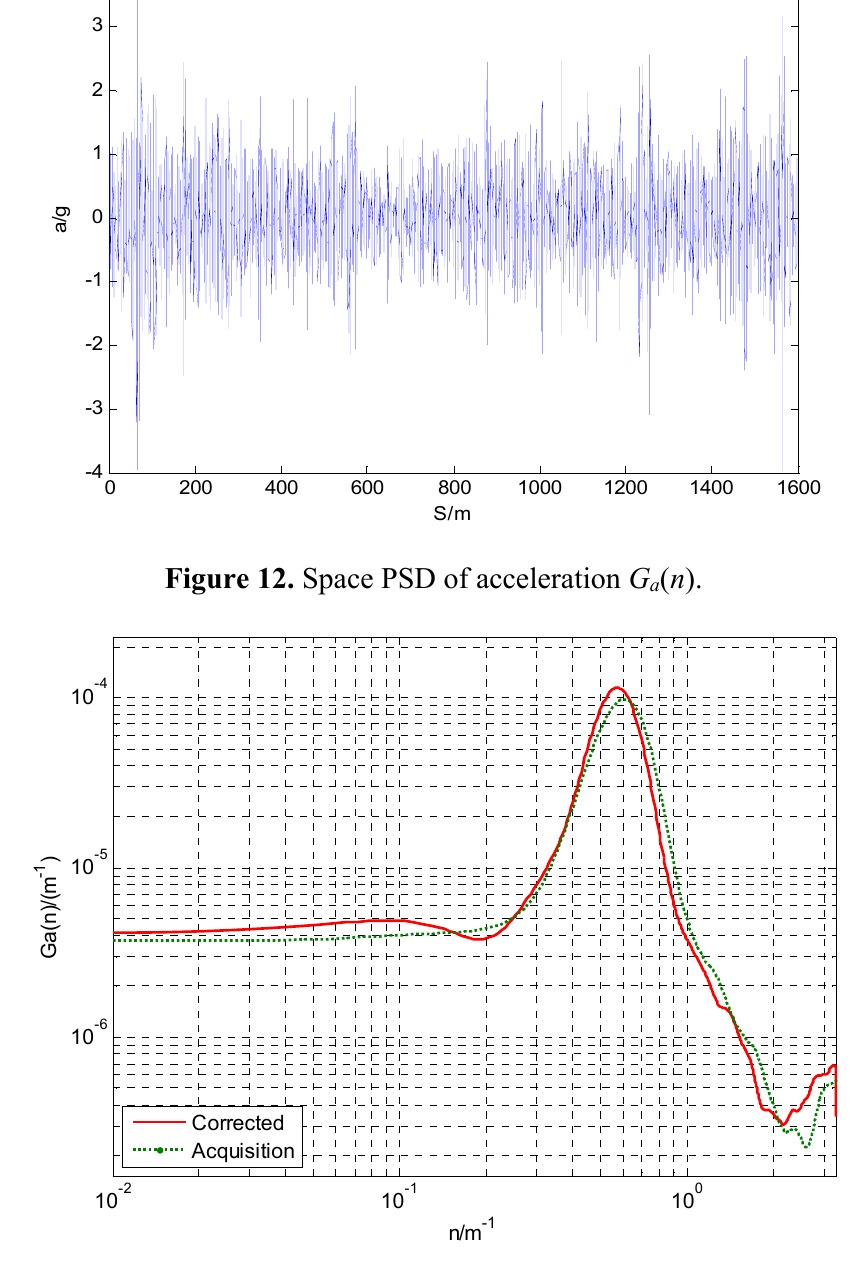
Figure 11. Acceleration response space history of the front wheel axle.